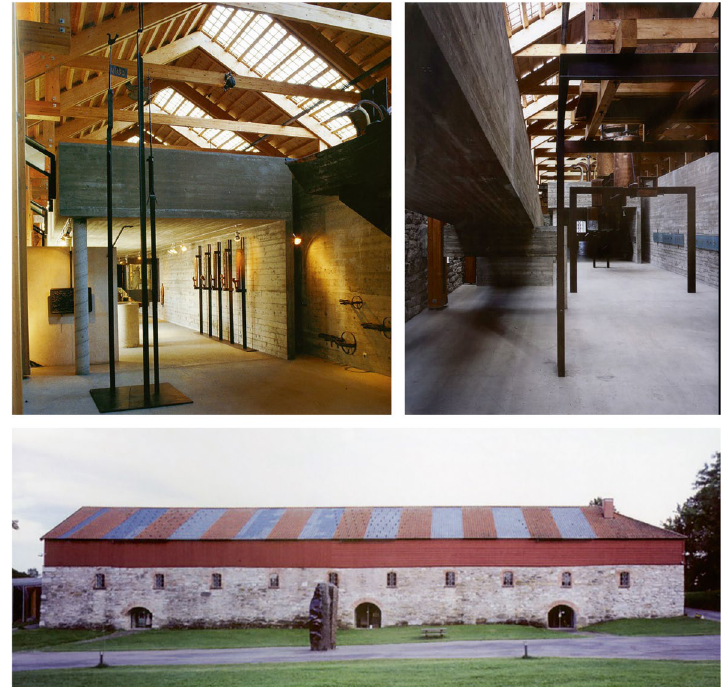
Fig. 8 Hedmark Museum, Hamar, Norway, 1967–2005, Sverre Fehn architect. (Source: Columbia University Avery